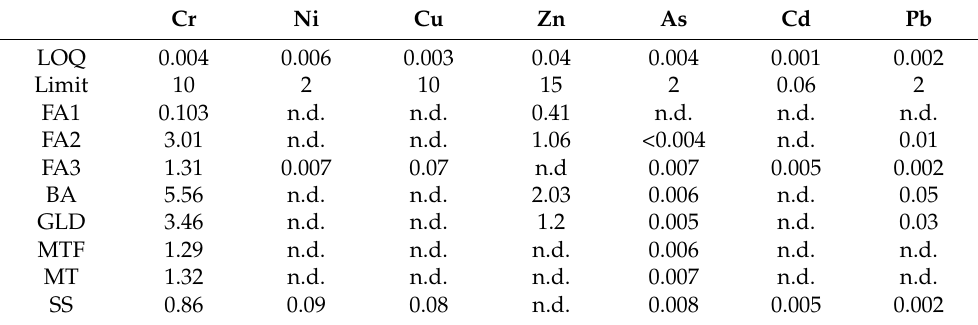
Table 8. Concentrations of different hazardous elements in samples after leaching, quantification limits (LOQ) and limit values for solubility of harmful substances (mg/kg, L/S = 10 L/kg) in fly ashes and bottom ashes generated from coal, peat, and wood according to the Finnish Government Decree 843/2017 [46], n.d.: not determined. Cr Ni Cu Zn As